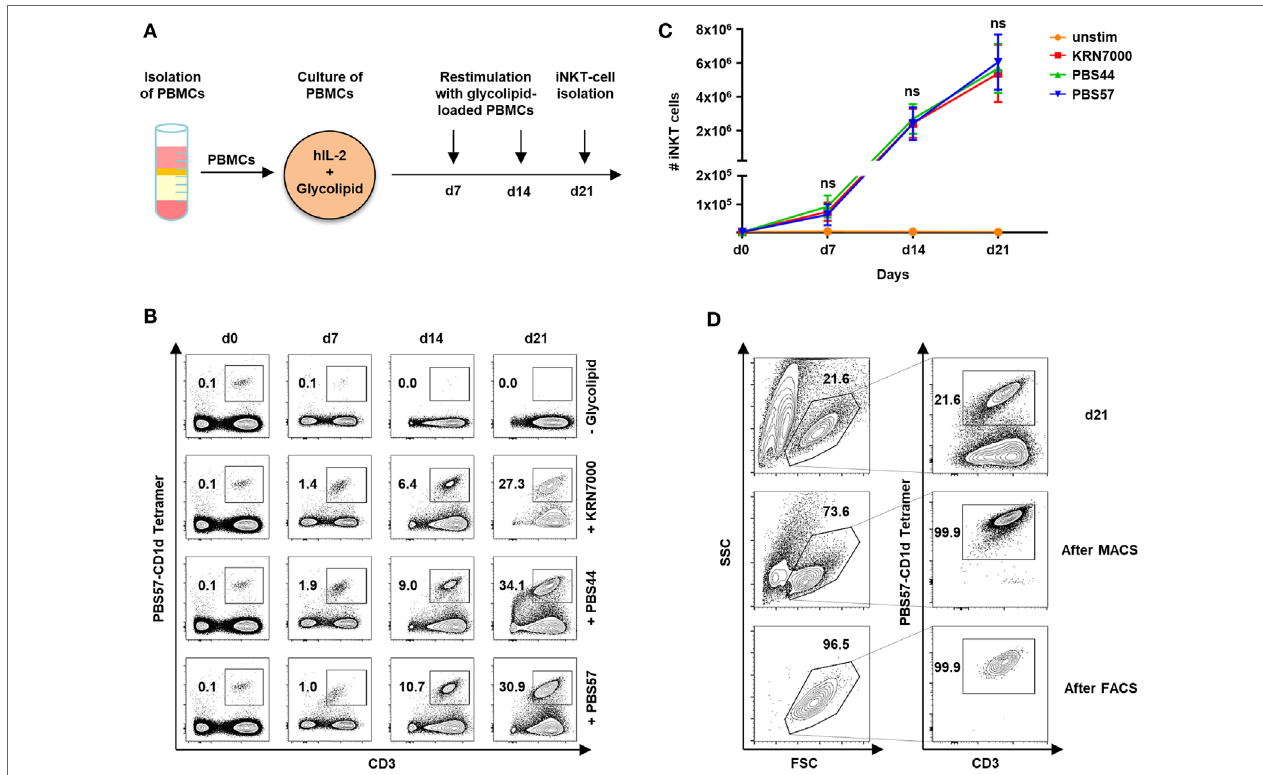
FigUre 1 | Ex vivo expansion and purification of human invariant natural killer T (iNKT) cells. (a) Scheme of iNKT-cell expansion from donor peripheral blood mononuclear cells (PBMCs) by glycolipid stimulation. iNKT cells were restimulated after 7 and 14 days with irradiated and glycolipid-pulsed autologous PBMCs. (B) Representative dot plots indicating percentage of iNKT cells cultured with KRN7000, PBS44, and PBS57 at days 0, 7, 14, and 21. All events were gated on live lymphocytes and iNKT cells were identified by expression of CD3 and staining with the PBS57-loaded CD1d tetramer. (c) Absolute iNKT-cell numbers during 21 days of expansion each starting from 2 × 10 6 PBMCs. Results for all tested glycolipid analogs [KRN7000 ( n = 9), PBS44 ( n = 9), and PBS57 ( n = 9)] are shown. Error bars indicate SEM. (D) Representative dot plots showing further purification of iNKT cells after 21 days of cell culture by magnetic-activated cell sorting (MACS) and fluorescence-activated cell sorting (FACS). FSC/SSC plots were gated on live lymphocytes and iNKT cells were identified by expression of CD3 and staining with the PBS57-loaded CD1d